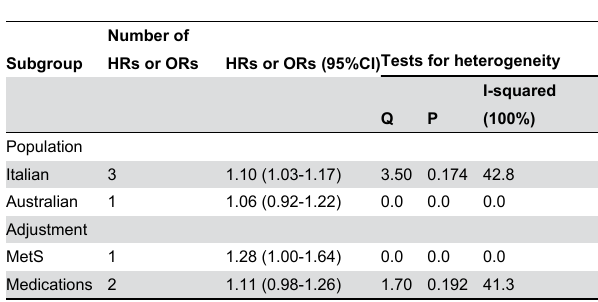
Table 3. Stratified analysis to summary hazards ratio for the relationship between SUA and T2DM